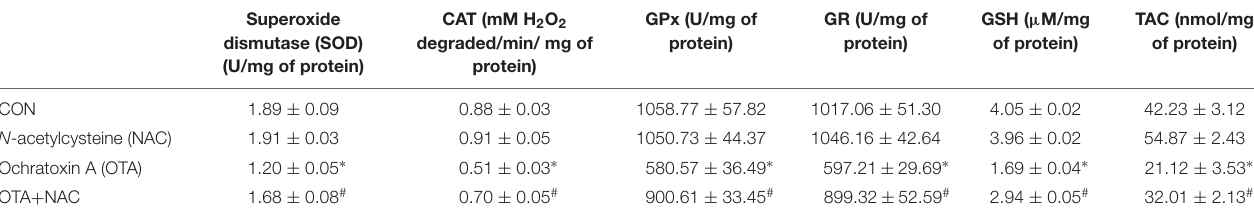
TABLE 2 | Effect of NAC on antioxidant